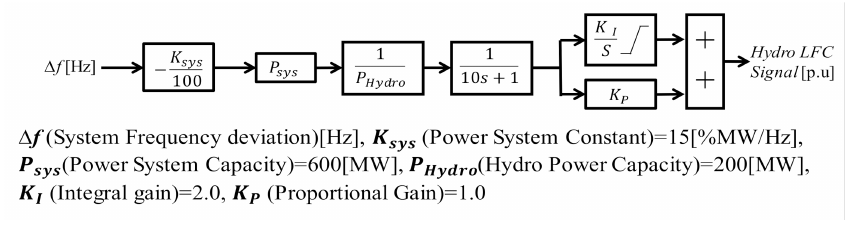
Figure 4. Load frequency control (LFC)